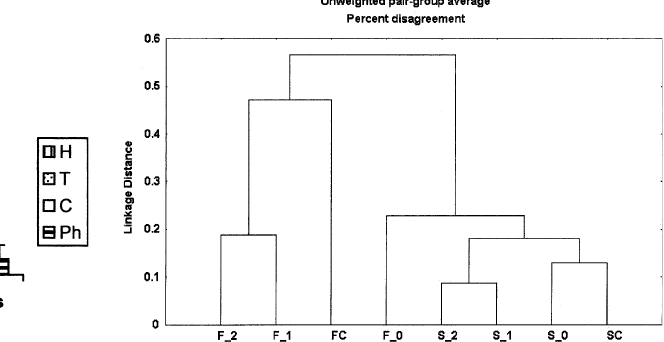
Fig. 3. Tree diagram representing the percent disagreement as linkage distance of the mean of presence-absence species in the three sites (A, B and C), in the field vegetation (F) and in the soil seed bank (S). C= control situation; 0, 1, 2= yr after